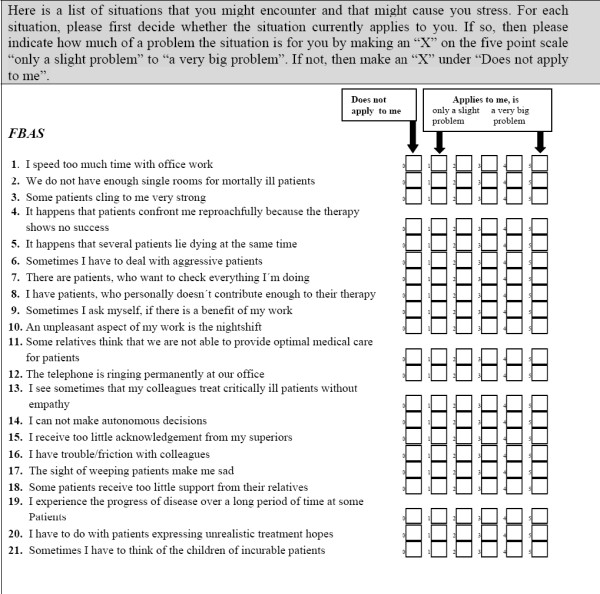
" Stress Questionnaire of physicians and nurses (FBAS), Herschbach 1989.